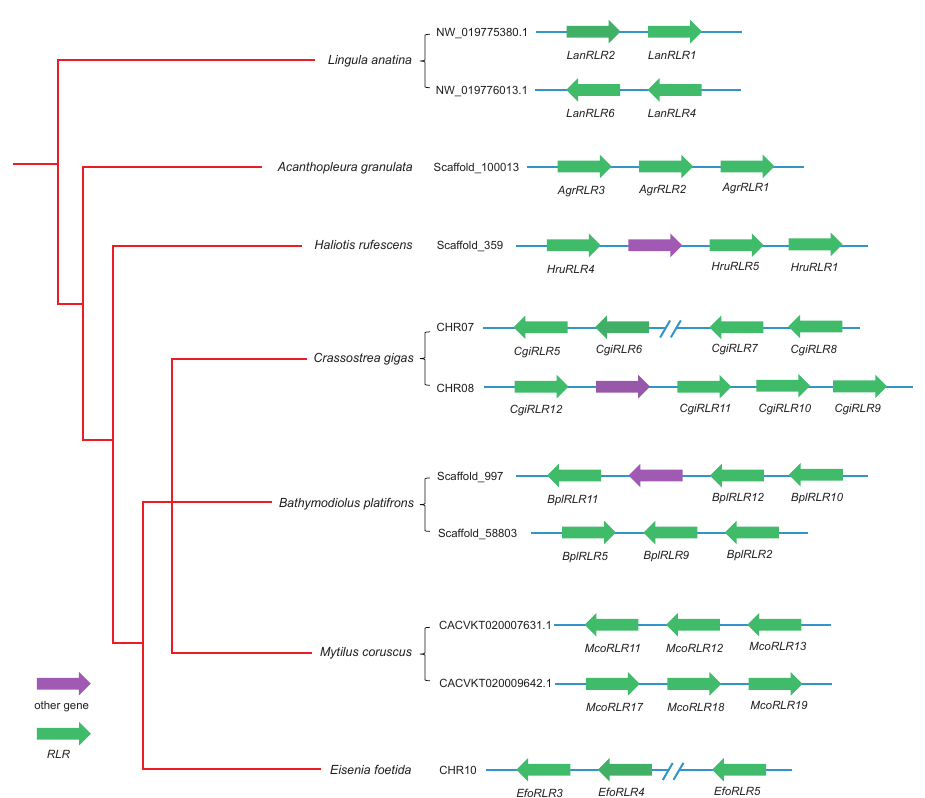
Figure 2. Local tandem duplication of RLRs in the seven representative lophotrochozoan species. Green arrowheads indicate RLR genes and their transcriptional direction; purple arrowheads indicate other genes. Phylogenetic relations among species are indicated by the red cladogram on the